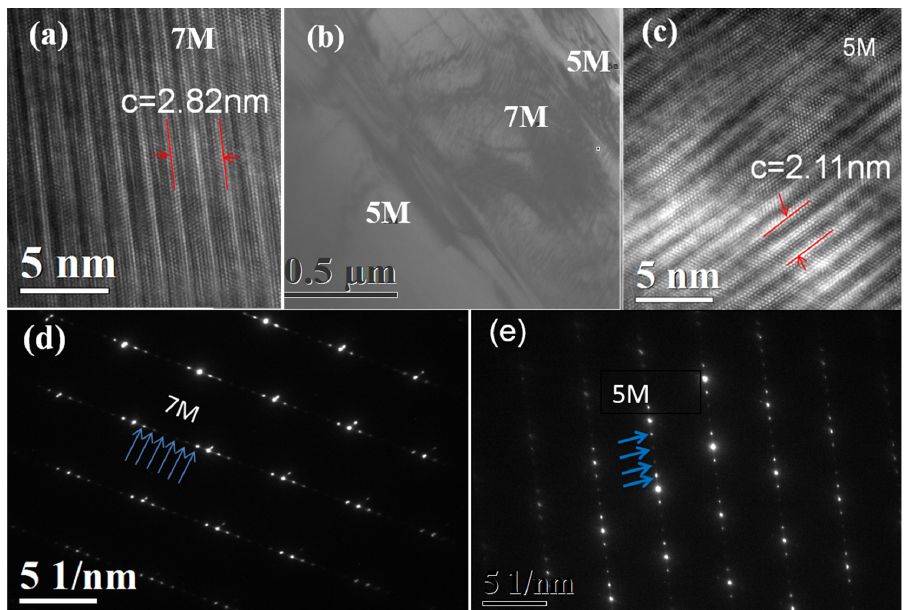
Figure 7. High resolution transmission electron microscopy (HRTEM) image of seven -layered modulated (7M) martensite for the Ga22-4 ( x = 5.5) alloy at room temperature ( a ), TEM bright-field image ( b ), HRTEM image of five-layered modulated (5M) martensite ( c ), and the corresponding selected area electron diffraction patterns (SAEDPs) of 7M ( d ) and 5M ( e ) martensites.